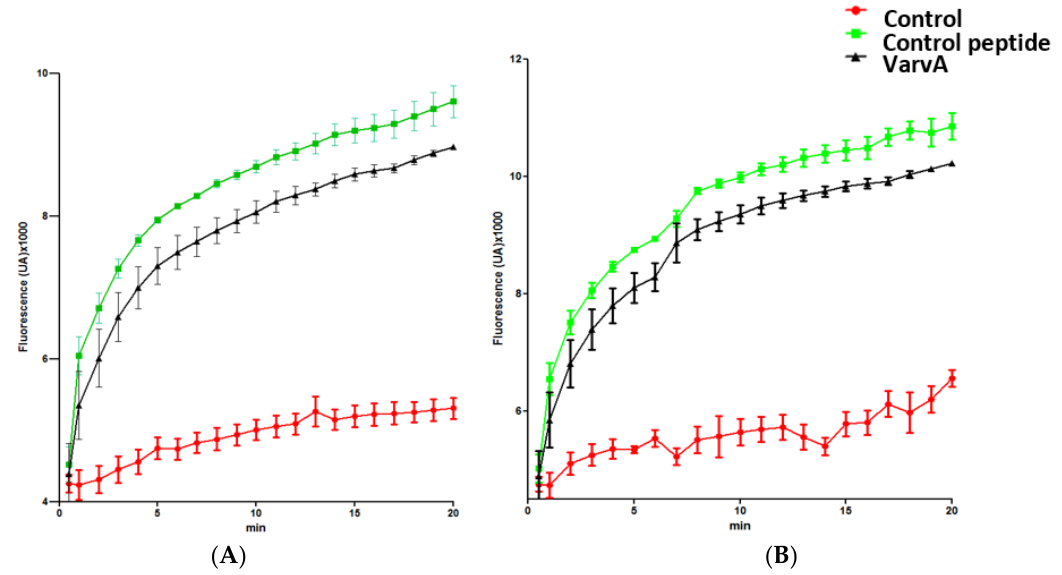
Figure 4. Bacterial membrane permeabilization induced by VarvA synthetic cyclotide. Membrane permeabilization influx of SYTOX Green in E. coli ( A ) and F. psychrophilum cells ( B ). The bacteria were exposed with 12.5 μM of VarvA synthetic cyclotide for 20 min in the presence of 5 µM SYTOX Green. Phospholipase-A2-derived synthetic peptide at 20 μM was used as a positive control. Negative controls were performed under the same conditions without the addition of peptide. The increase in fluorescence was recorded at 30 s intervals with the SYBR green filter.